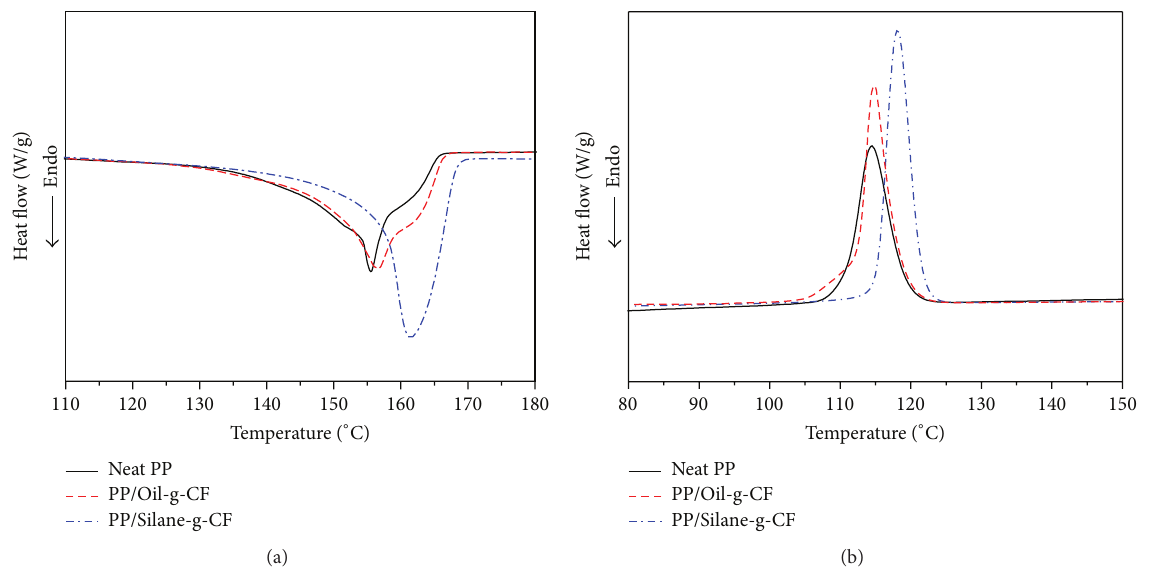
Figure 8: DSC thermograms of neat PP, PP/Oil-g-CF composite, and PP/Silane-g-CF composite: (a) second heating curves and (b) second cooling